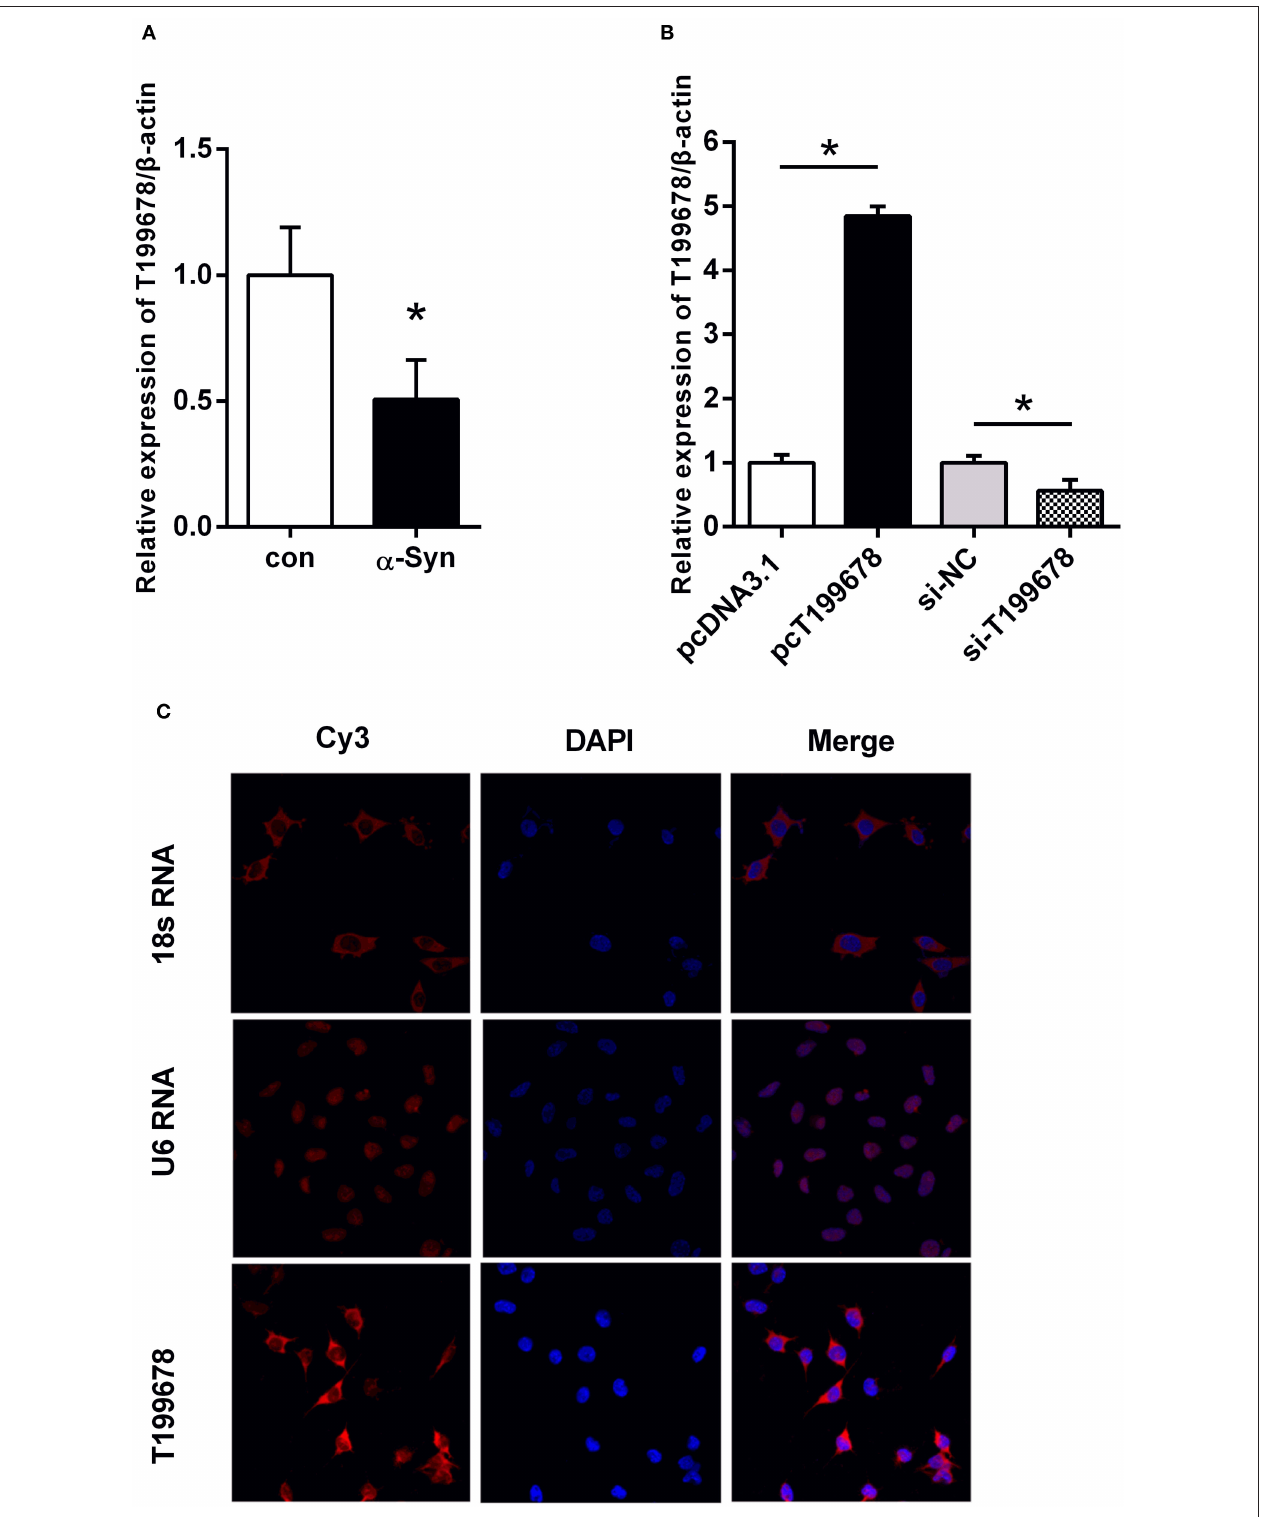
FIGURE 1 | The level and sub-localization of lncRNA-T199678 in α -Syn-challenged SH-SY5Y cells . (A) Relative expression of lncRNA-T199678 was markedly decreased in α -Syn-challenged SH-SY5Y cells by qPCR ( p < 0.05, compared with the control group). (B) Relative expression of lncRNA-T199678 in lncRNA-T199678 overexpression and silencing cell lines by qPCR. (C) Sub-localization of lncRNA-T199678 in SH-SY5Y cells. Taking U6 located in the nucleus and 18S located in the cytoplasm as the control, most lncRNA-T199678 in the SH-SY5Y cell line were located in the cytoplasm. * P < 0.05.